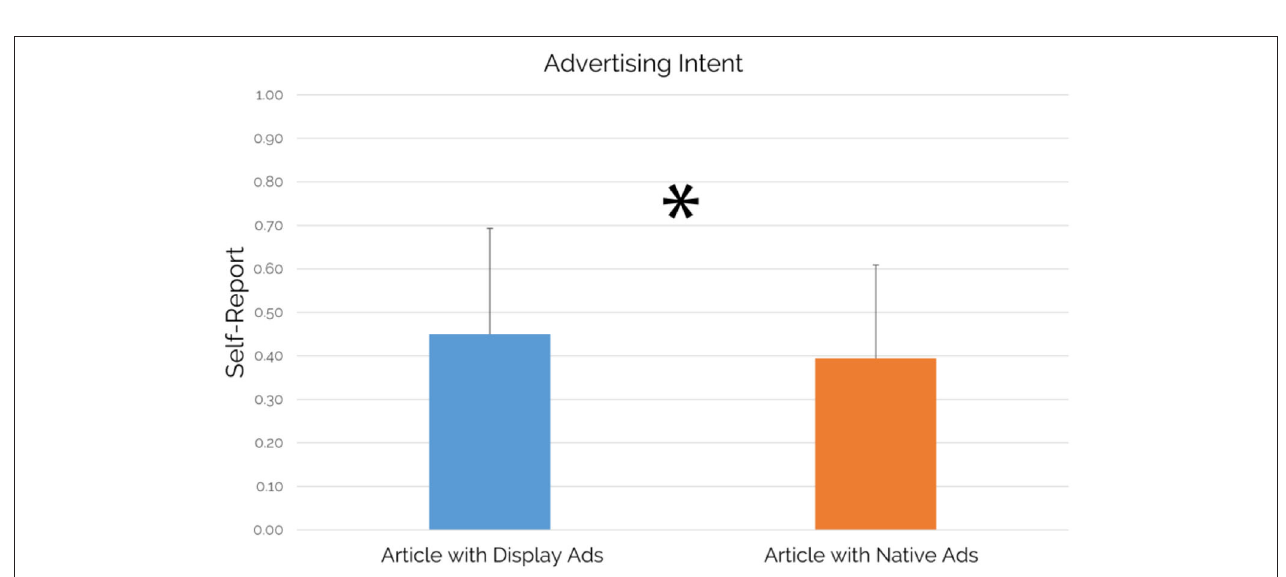
FIGURE 8 | Self-reported Advertising Intent: comparison between an article containing display ads and an article containing native ads ( n = 49). An article containing display ads showed a statistically significant increase in self-reported Advertising Intent values in comparison to an article containing native ads ( p = 0.035, d = 0.31). Error bars represent standard